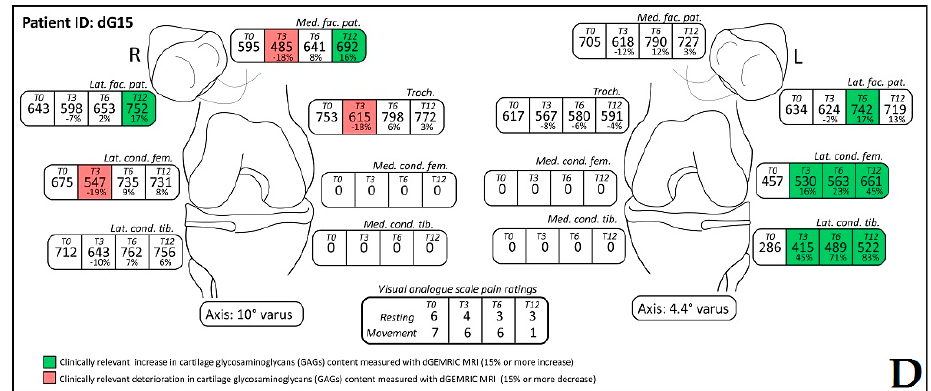
Figure 1. (Patient dG15) Coronal ( A ) and sagittal ( B ) magnetic resonance (MR) images show complete